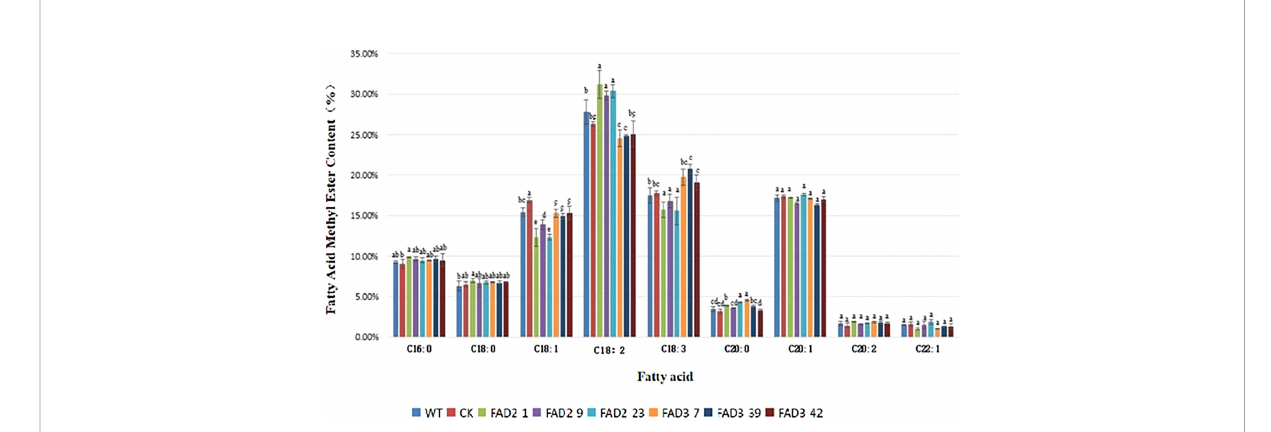
FIGURE 2 Fatty acid pro fi les and fatty acid methyl ester levels in the transgenic and WT A. thaliana seeds.